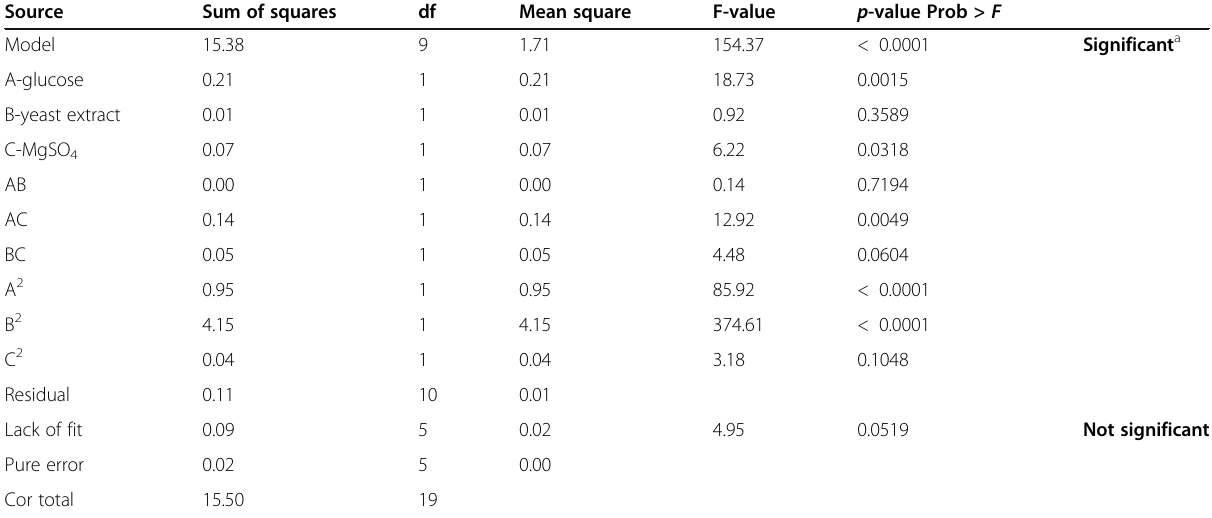
Table 6 ANOVA for response surface quadratic model